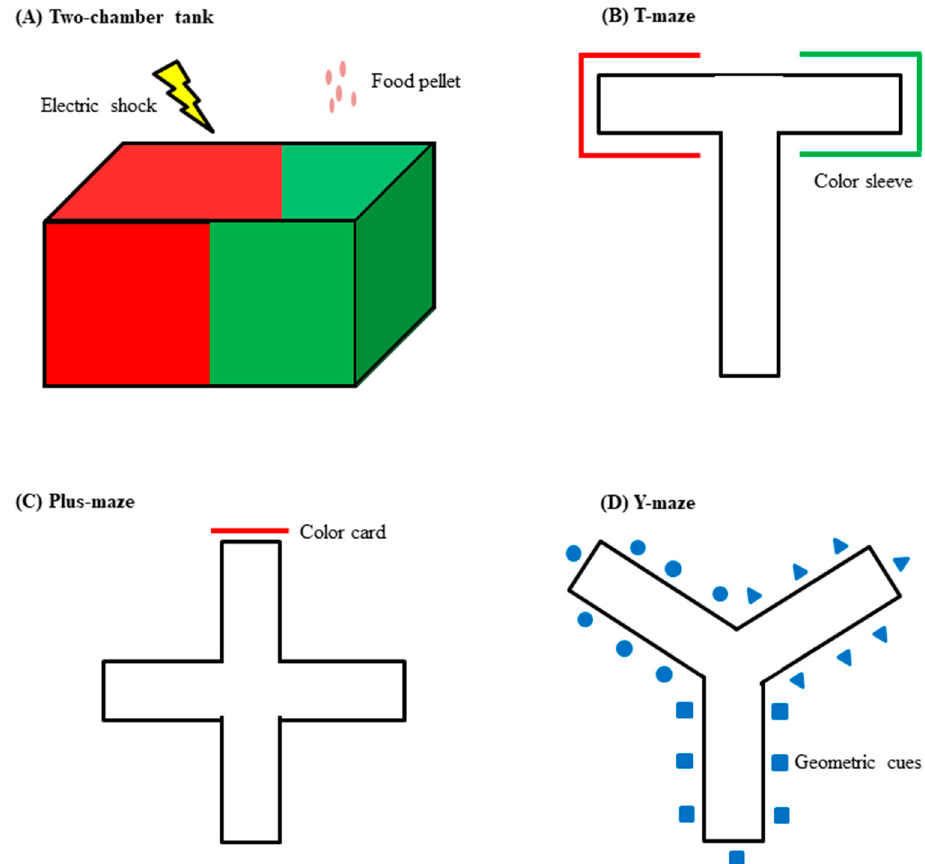
Figure 1. Types of tank or maze used for cognitive tests in zebrafish. ( A ) Two-chamber tank colored coded as a visual cue, for example. The unconditioned stimulus can be appetitive such as a food reward, or aversive such as an electric shock; ( B ) T-maze; ( C ) Plus-maze; ( D ) Y-maze. The arms of the mazes can be coded with different color or geometric cues.